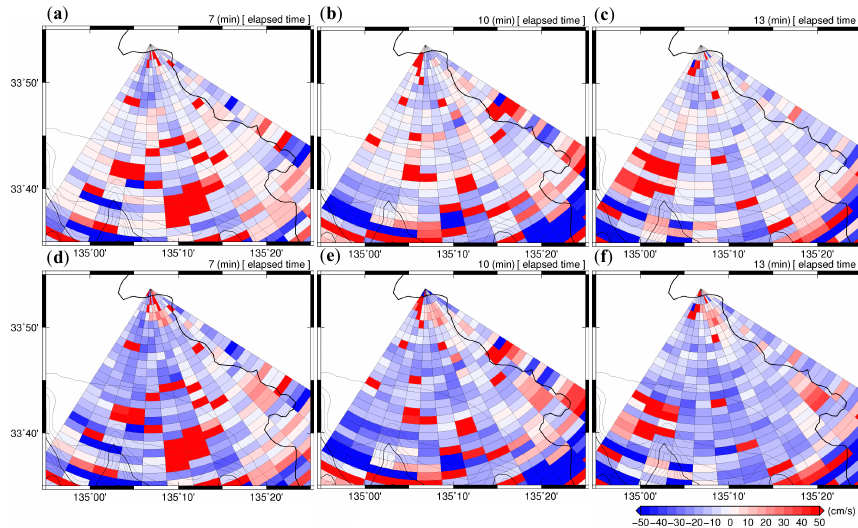
Figure 5. Same as Figure 4, but for the 02271300 scenario.